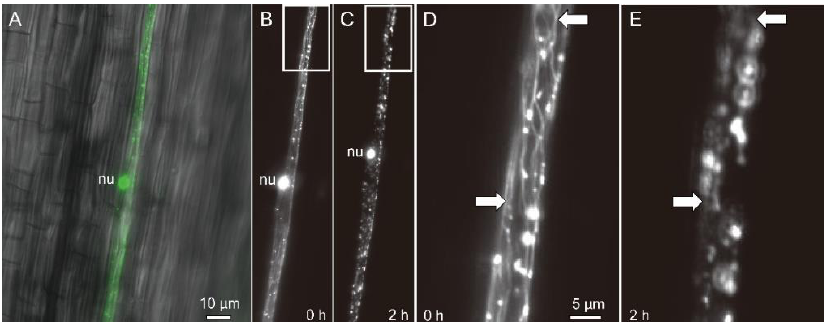
Figure 3. Subcellular localisation of OsDLK in response to cold stress in etiolated coleoptiles of O. sativa ssp . Japonica ‘Nipponbare’ visualised by a GFP fusion. ( A ) Representative epidermal cell after biolistic transformation (overlay of GFP signal on the differential interference contrast image). ( B – E ) OsDLK-GFP signal collected by spinning disc microscopy prior to ( B , D ) and 2 h ( C , E ) after administering cold stress (0 °C). Survey images ( B , C ) and zoom-ins of the region highlighted by the white boxes ( D , E ) are shown. White arrows in ( D , E ) indicate cortical microtubules ( D ) that are eliminated under cold stress. Note the shift of the nucleus (nu) towards the cell apex concomitant to the elimination of microtubules ( B , C ).